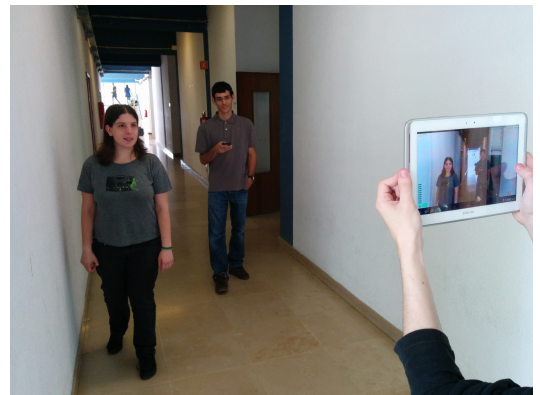
Figure 1: ARZombie: Game